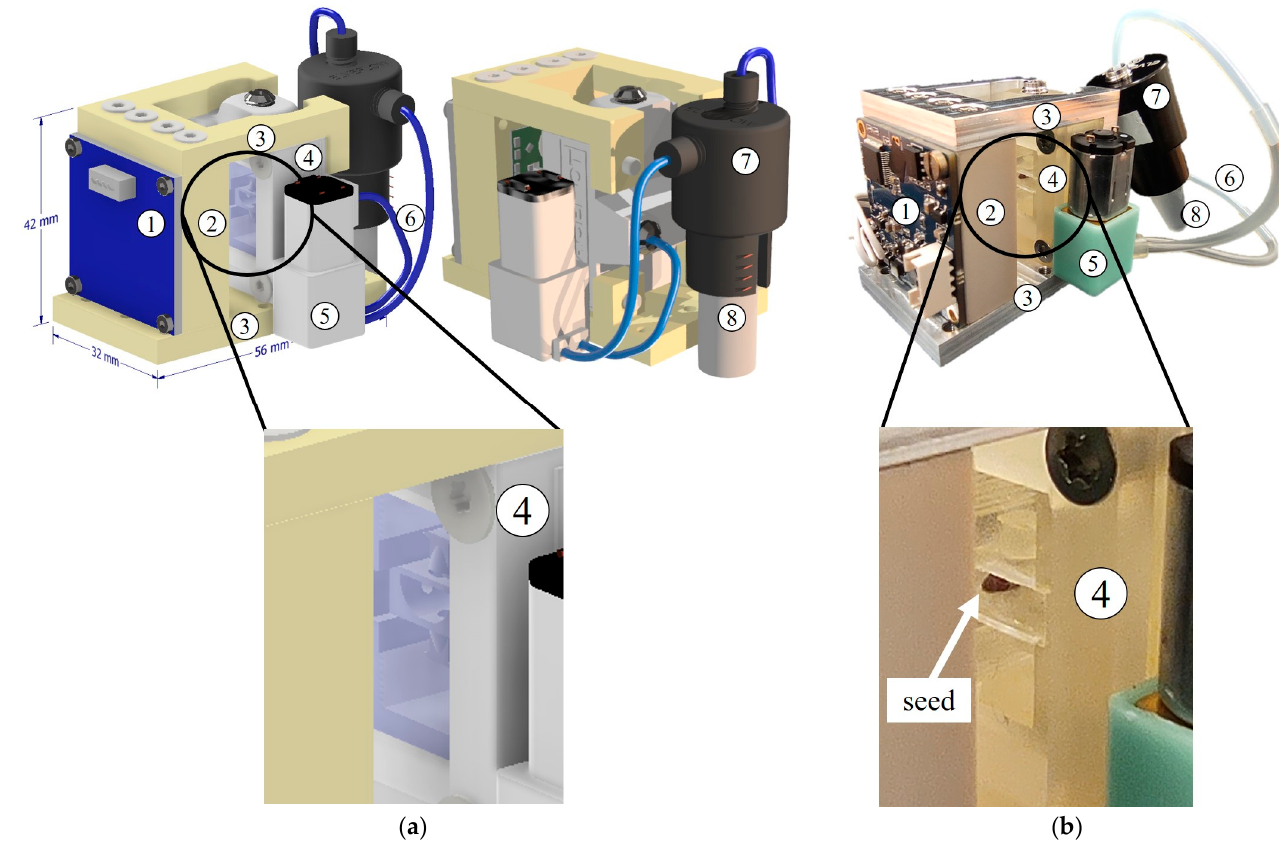
Figure 3. Assembled micropot payload with optical and nutrition modules: ( a ) CAD visualisation; and ( b ) ready to use set-up. (1) Camera chip, (2) LED and autofocus housing, (3) micropot detection module frame, (4) 3D-printed micropot, (5) microfluidic peristaltic pump, (6) microfluidic tubes, (7) Eppendorf fluidic connector, and (8) 1.5 mL Eppendorf enclosure.